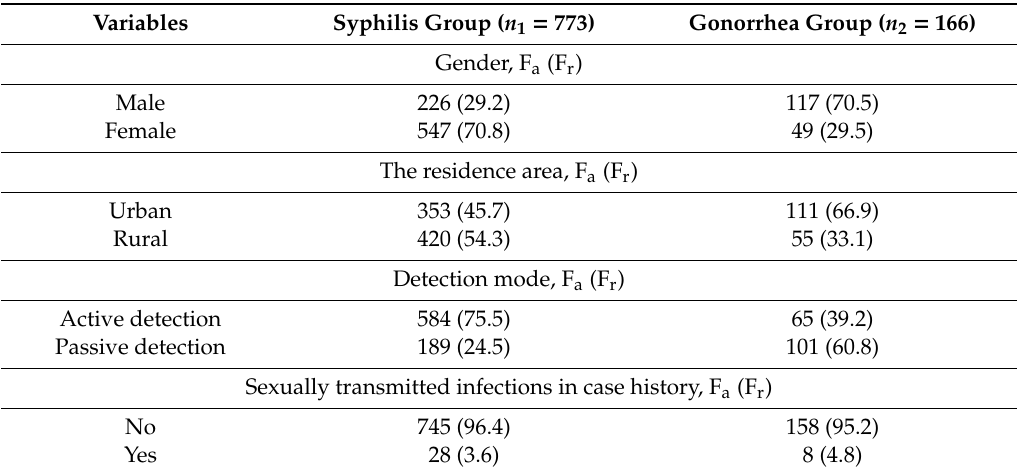
Table 1. Syphilis and gonorrhea frequencies in relation to demographic and epidemiological variables.